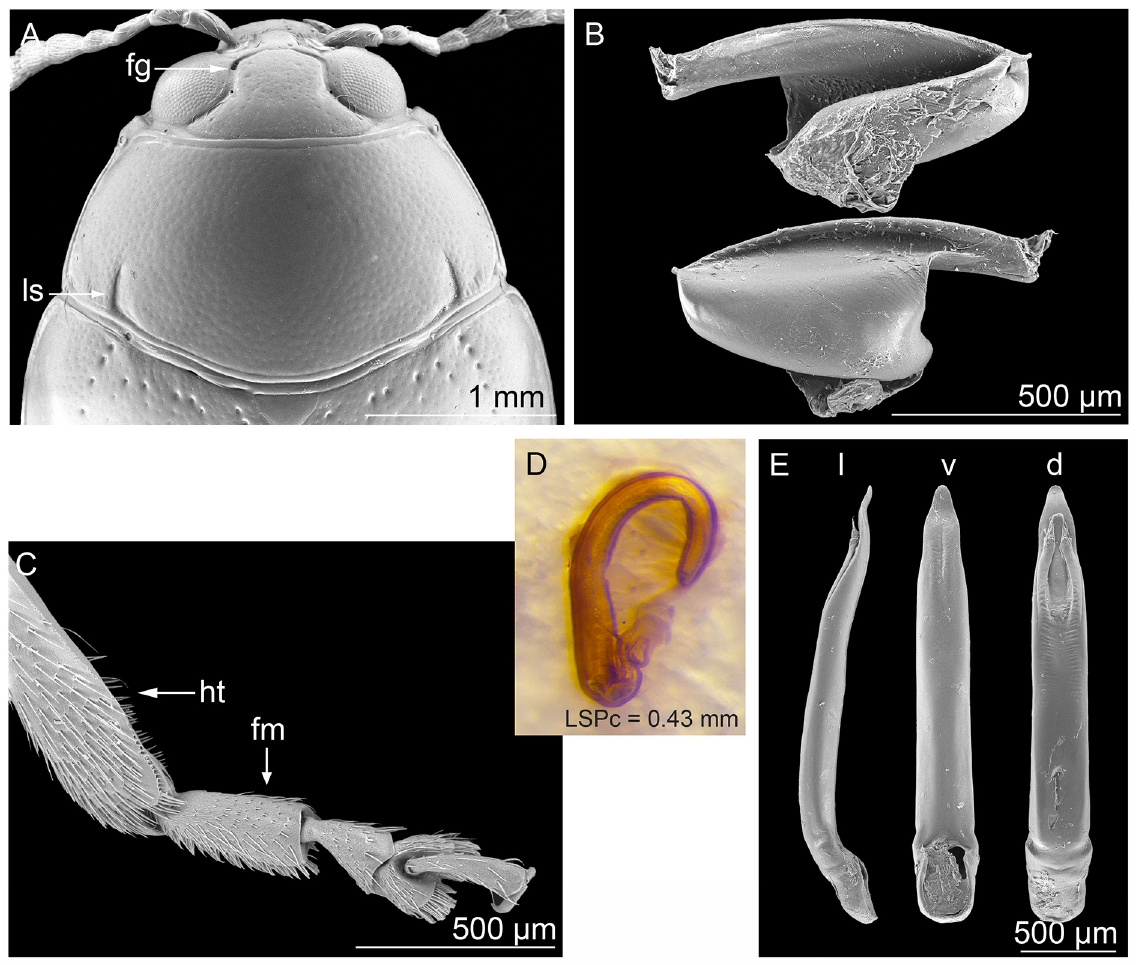
Fig. 12. Morphological traits of Arsipoda bifrons Erichson, 1973. A . Head and pronotum. B . Metafemoral spring. C . Hind tibia and tarsus. D . Spermatheca. E . Median lobe of aedeagus in lateral (l), ventral (v) and dorsal (d) views. A–C, E: Australia (BAQ); D: Australia, Byron Bay (BAQ). Abbreviations: fg = frontal grooves; fm = first metatarsomere; ht = hind tibia; ls = longitudinal striae; LSPc = length of spermathecal